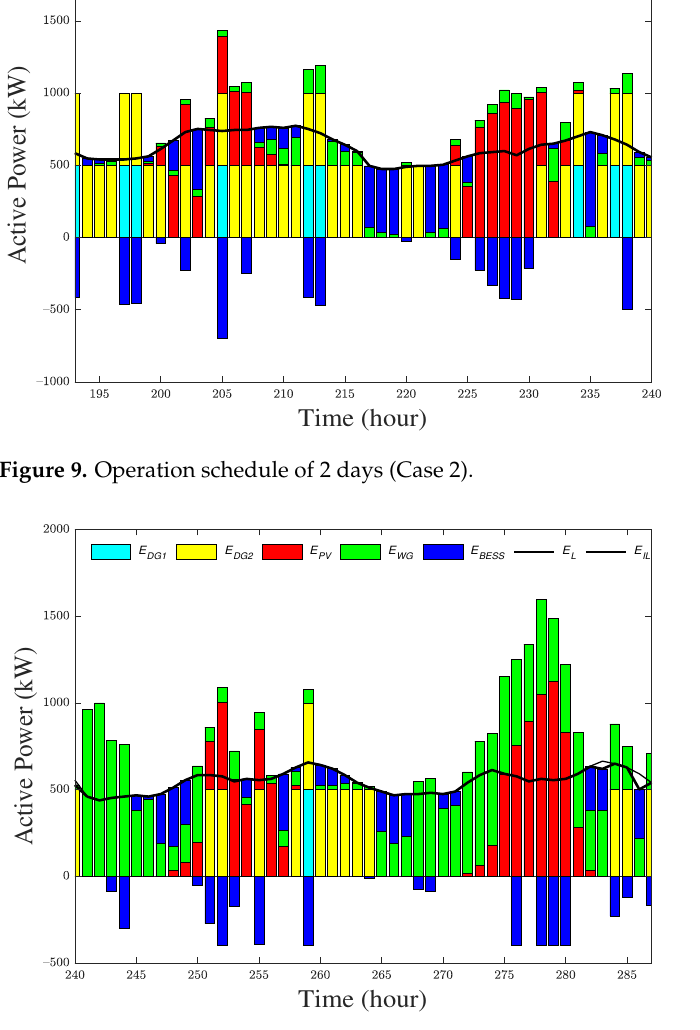
Figure 10. Operation schedule of 2 days (Case